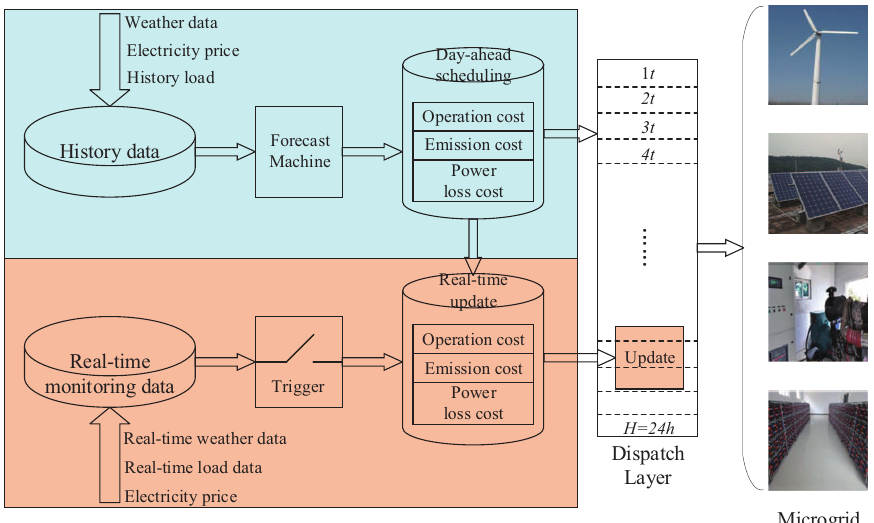
Figure 1. The block diagram of two-stage dispatch (TSD) for a